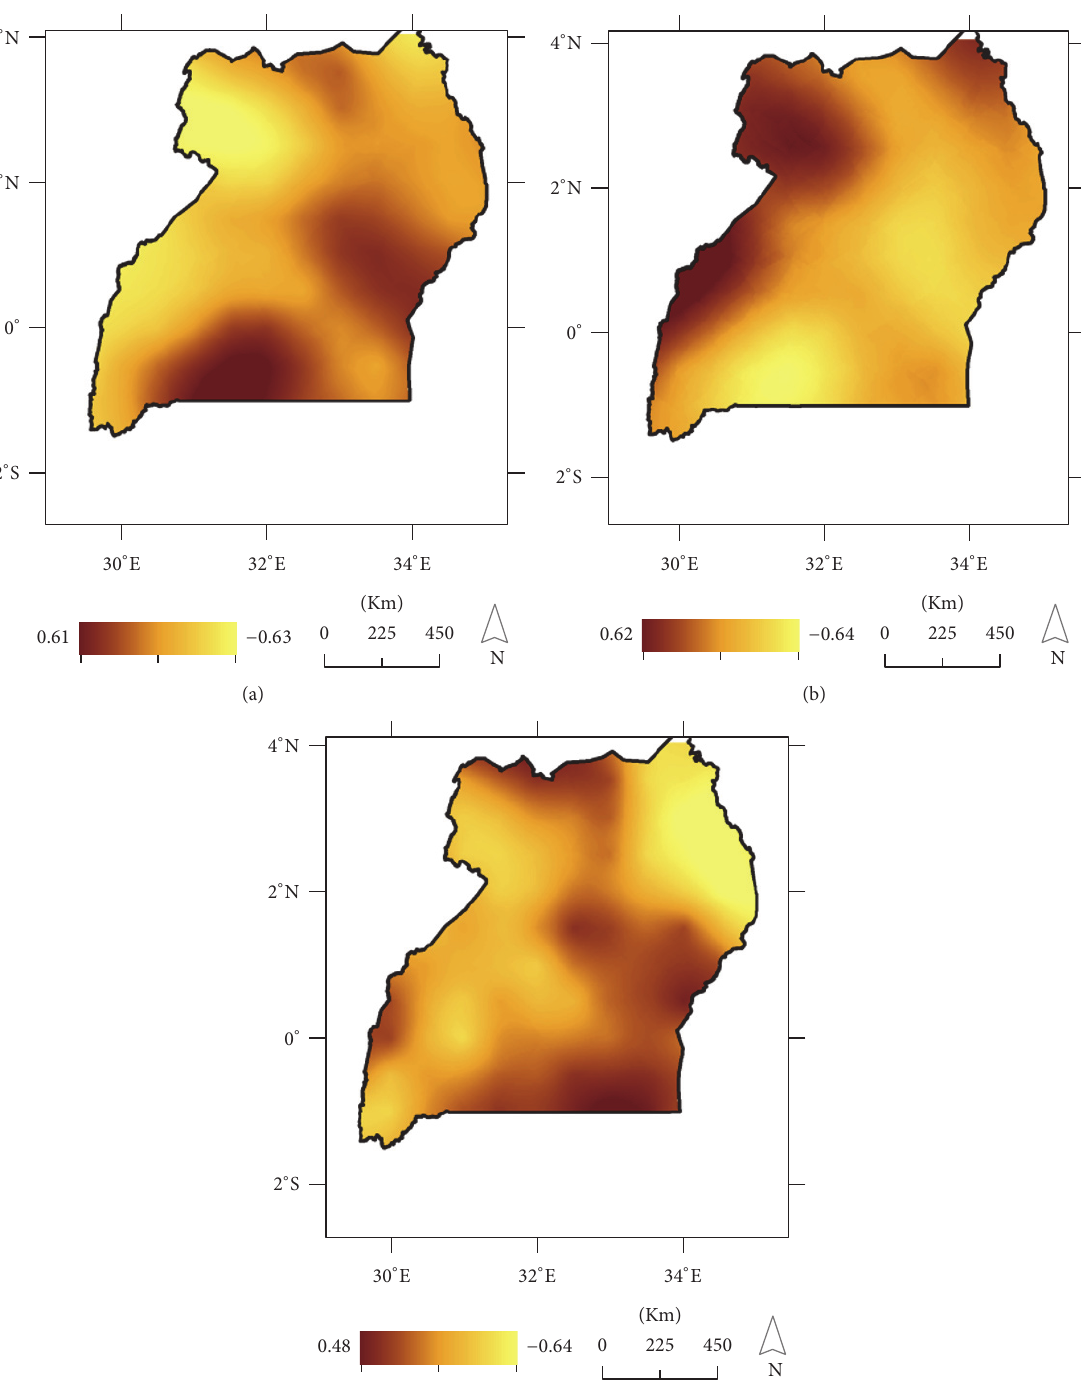
Figure 8: Correlation between NAIM anomalies from rainfall and those of (a) IOD, (b) NAO, and (c) Ni˜no 3.